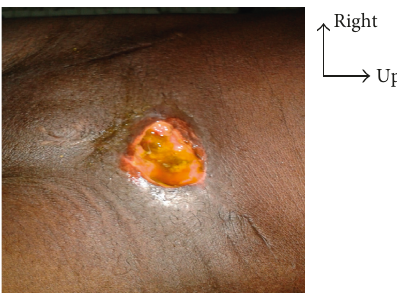
Figure 1: Flow of stools through a left inguinal tumefaction facing wound.